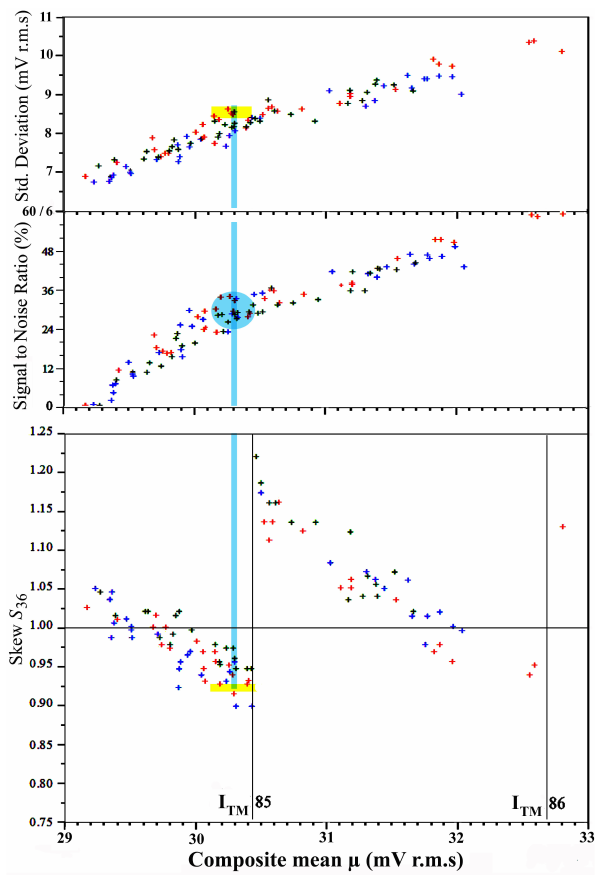
Fig. 6. Global summary chart of simulation S1. Highlighted yellow areas cover the bin 36 experimental ranges of mean amplitude µ , standard deviation σ and normalized skew S , during the ground se- quence. The blue disc (middle panel) demarcates the most probable area for SNR. Green, red and blue crosses correspond to simulation runs based upon surface noise bins 12, 24 and 48, respectively.